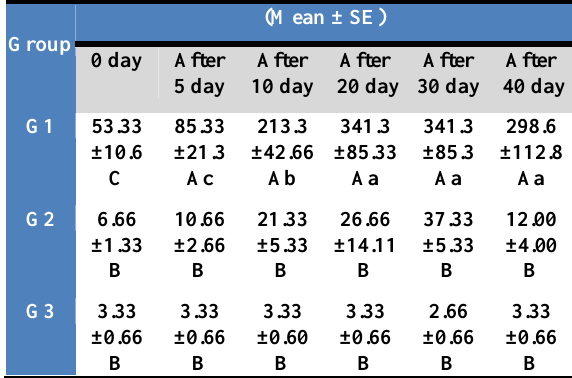
Table, 4: Antibody titers in serum of immunized and control groups (Mean ± SE).